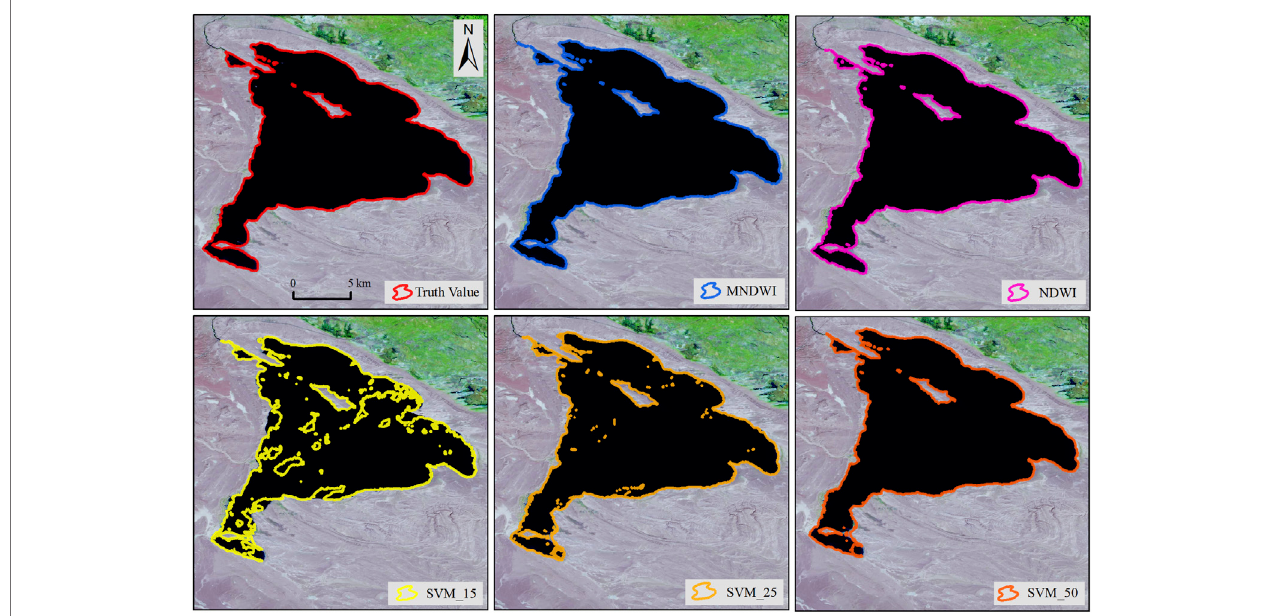
FIGURE 2 | Comparison ofsurface water extraction results by NDWI, MNDWI, and SVM. The base map is the Sentinel-2 MSI image acquired on 26 August 2021.